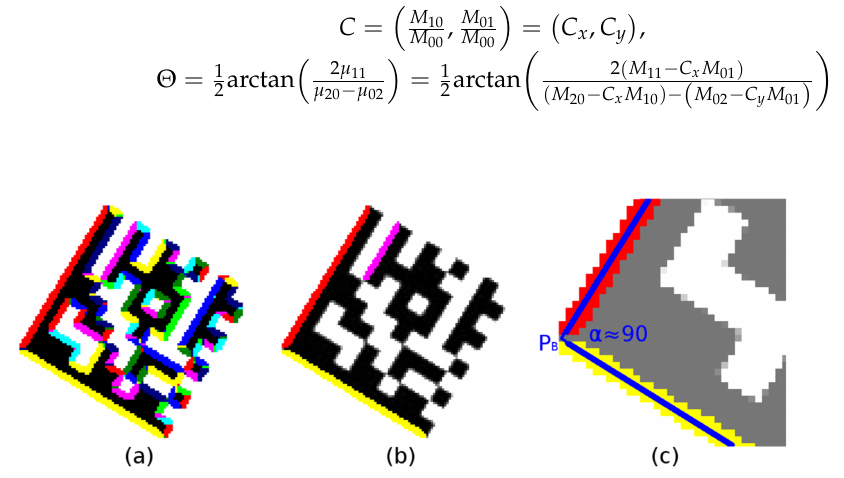
Figure 4. ( a ) colored continuous regions; ( b , c ) significant linear